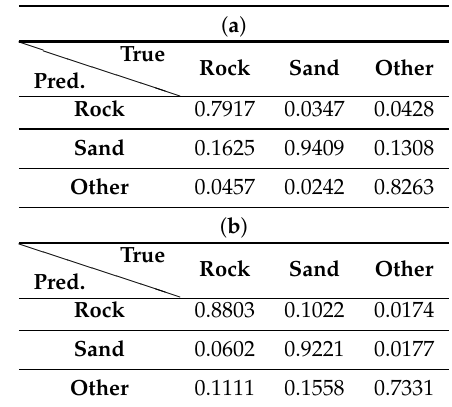
Table 3. Confusion matrices for SCM normalized ( a ) column-wise ( b ) row-wise .